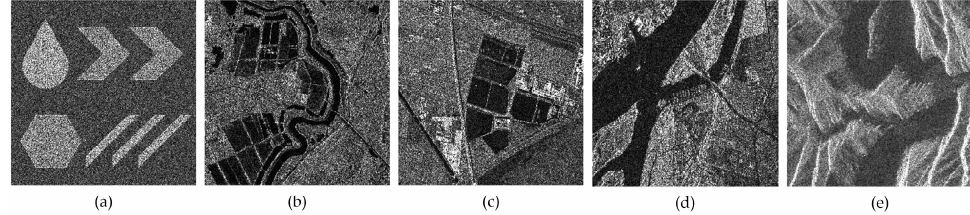
Figure 5. ( a ) Added single-look speckled image (the mean is 1 and the variance is 0.1), ( b ) GF-3 SAR image, ( c ) TerraSAR-X SAR image, ( d ) RadarSAT-2 SAR image, and ( e ) ALOS-2 SAR image.